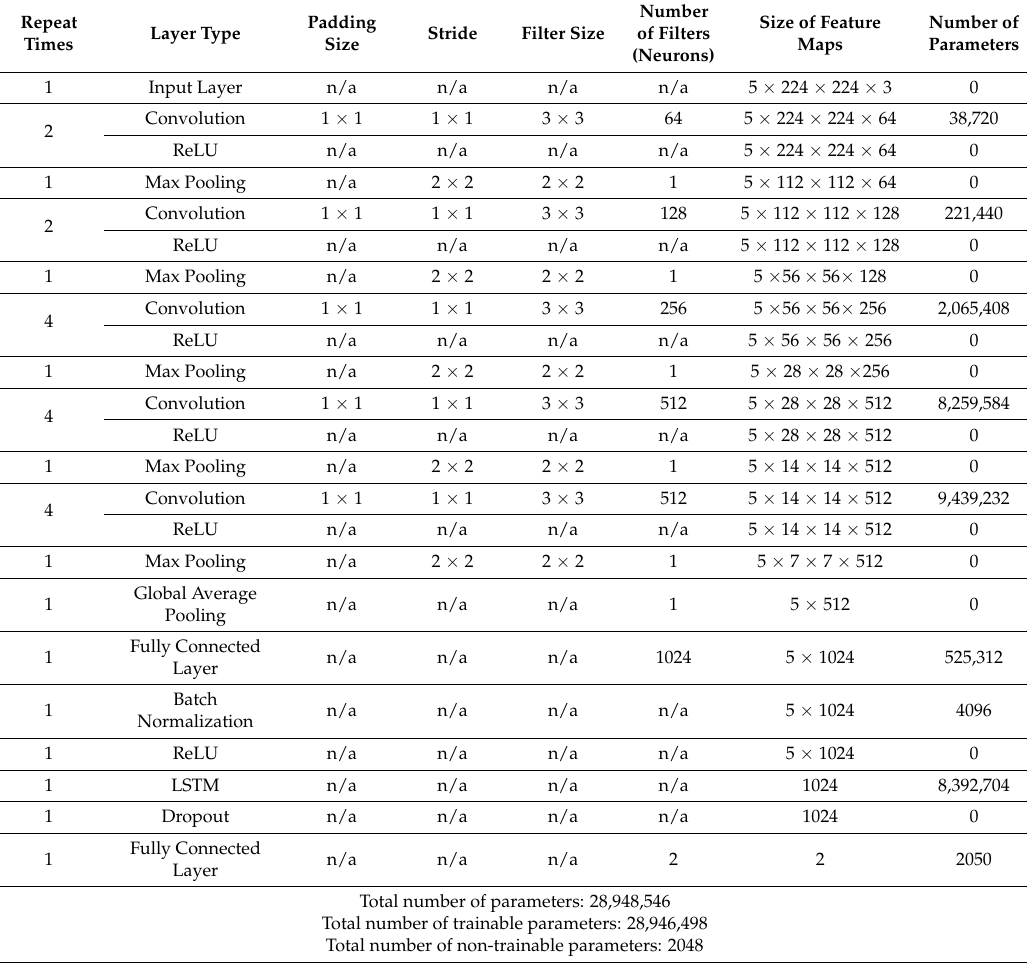
Figure 4. General architecture of a stacked CNN-RNN network for temporal image extraction. Table 2. Detailed description of architecture of the stacked CNN-RNN network in our